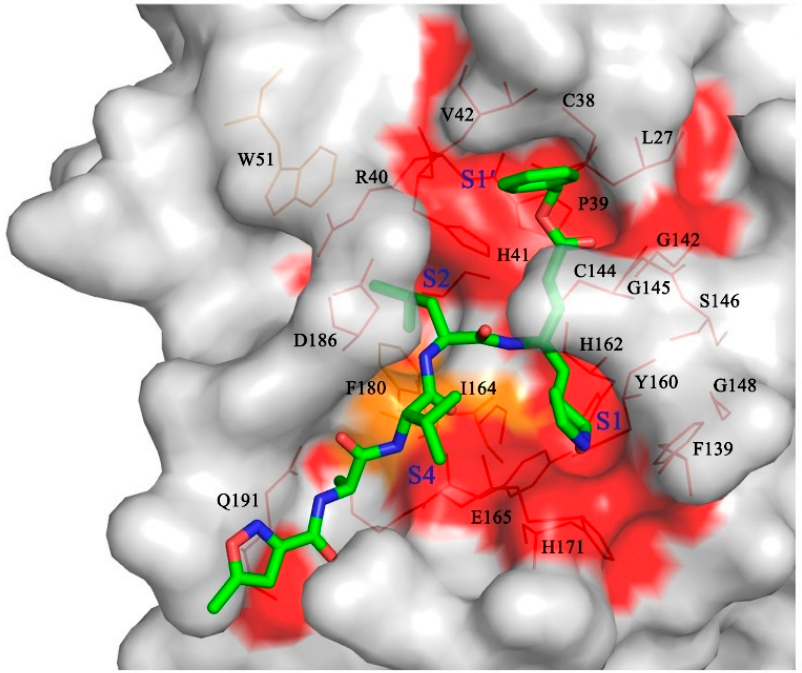
Figure 4. Structure-based substrate-binding pocket conservation analysis of M pro s from four different genera. Surface representation showing the conserved substrate-binding pockets from the ten CoV M pro s listed in Figure 2B. The background is PDCoV M pro . Red: identical residues among all ten CoV M pro s; orange: substituted in two CoV M pro s. The S1, S2, S4, and S1 ′ pockets and the residues that form the substrate-binding pocket are labeled. N3 is shown in green.